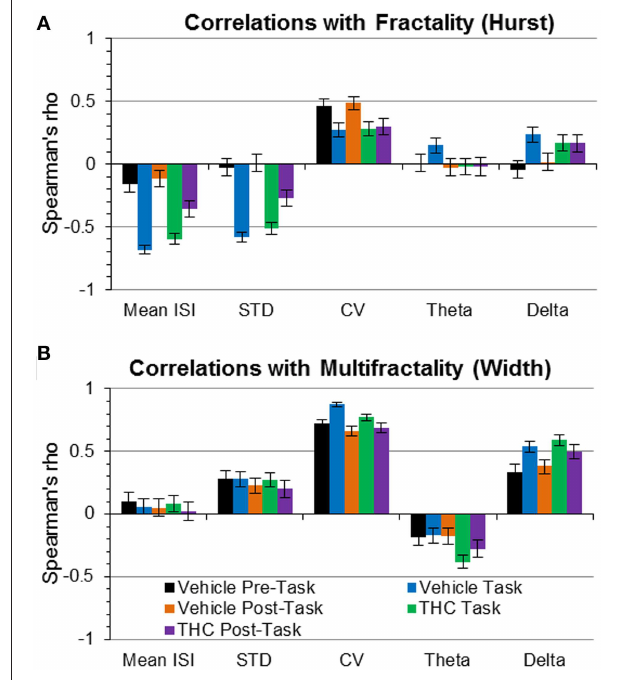
FIGURE 9 | Correlations of fractality (Hurst exponent) and multifractality (singularity spectrum width) with spike train variability and frequency spectrum measures. Correlations (Spearman’s rho) are plotted with 95% confidence intervals as error bars. (A) The Hurst exponent is negatively correlated with mean ISI and ISI STD during task recordings independent of drug condition—indicating that faster spiking and less variable firing patterns are correlated with greater LRTCs during the task only. (B) The coefficient of variation (CV) was positively correlated with multifractal complexity (width)—indicating “burstiness” correlates with multifractality. Delta power was positively correlated with multifractality (width) during the task phase, regardless of drug